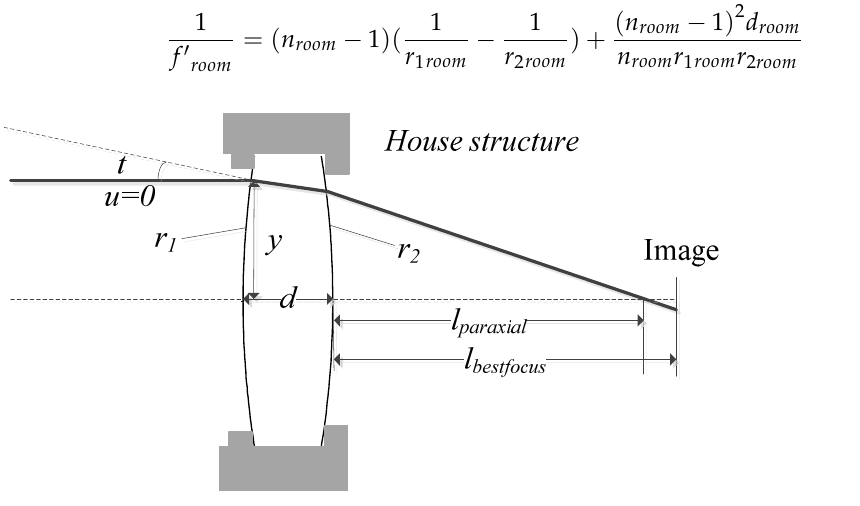
Figure 8. Single lens example.